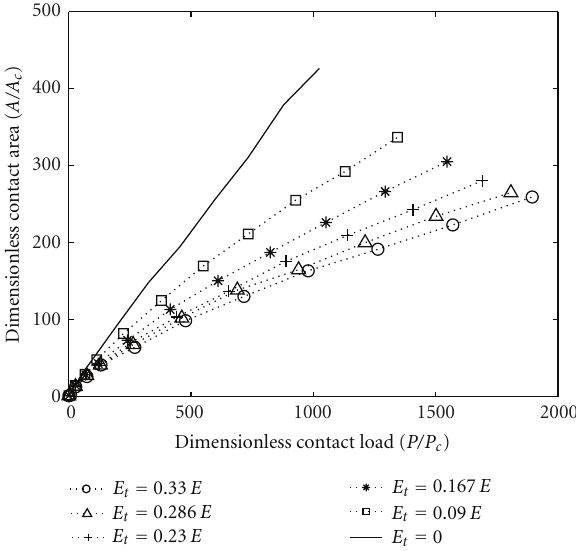
Figure 9: Dimensionless contact load against dimensionless inter- ference for kinematic and isotropic material